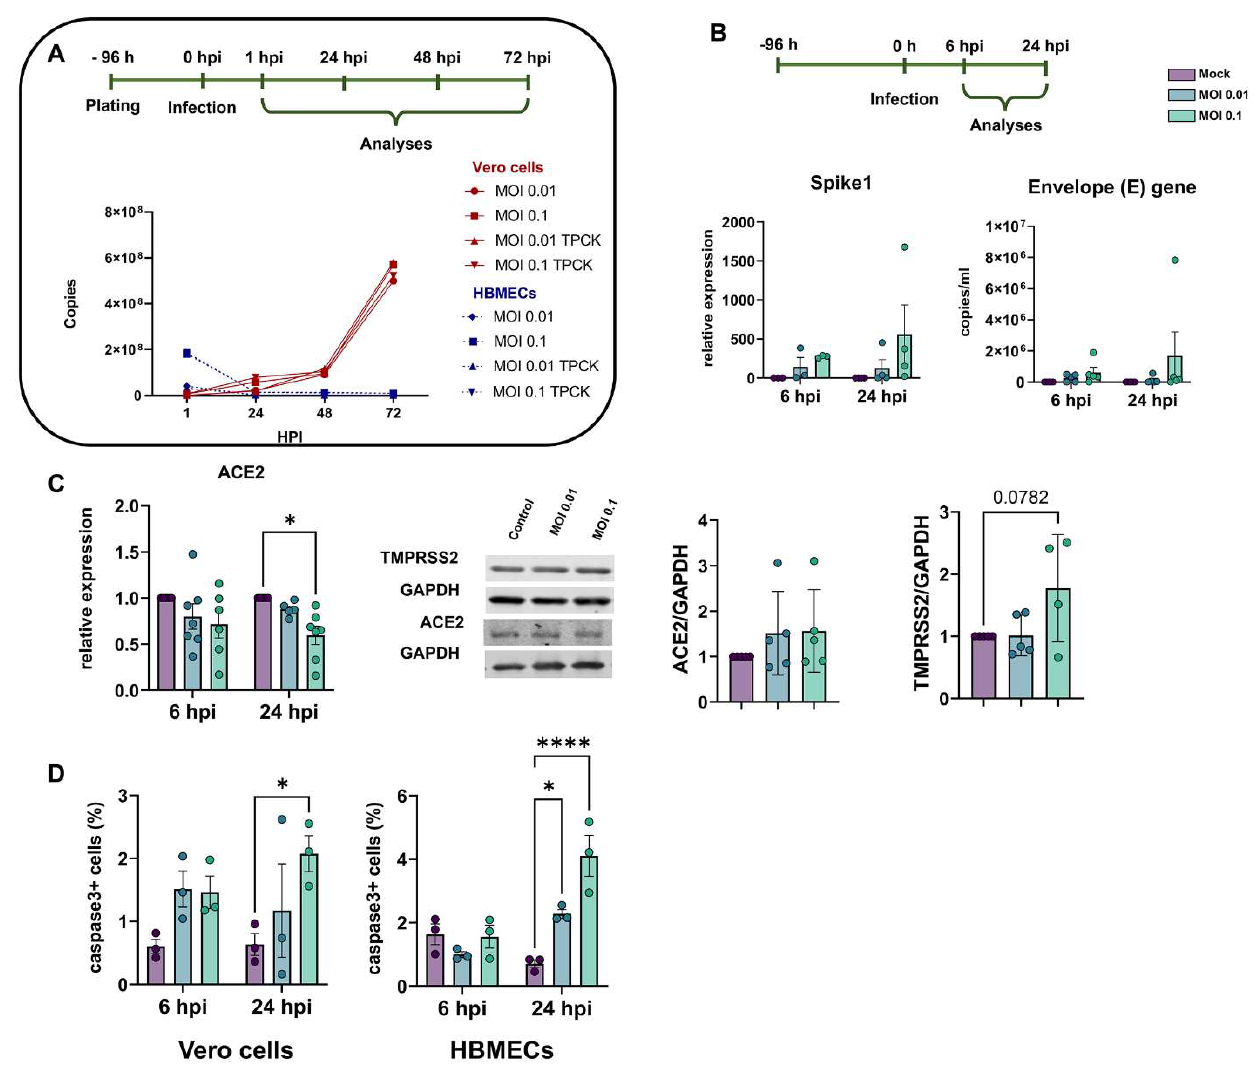
immunoreactivity to cleaved caspase-3, an executioner of apoptosis (Figure 1D). MOIs 0.01 and 0.1 resulted in 2.27 and 4.1% of caspase-3-positive cells, respectively, whereas non-infected dishes showed a physiological rate of 0.7% of stained cells. The apoptotic 0.01 affected the ZO-1 fluorescence signal in HBMECs after 24 h of exposure by 1.19-fold stimulus was also observed in Vero E6 cells 24 h after the challenge with MOI 0.1 (Figure (Figure 2B). ZO-1 and claudin-5 mRNA expression remained unaltered in HBMECs after 6 1D). Positive control with 0.5 and 2.0 µ g Staurosporine for 2 h led to 1.9 and 9% of caspase- and 24 h of the SARS-CoV-2 challenge (Figure 2C), but their protein levels were significantly 3 positive HBMECs, respectively (not shown). increased by 2.0- and 1.17-fold by the MOI 0.1 at 24 h, respectively (Figure 2D).